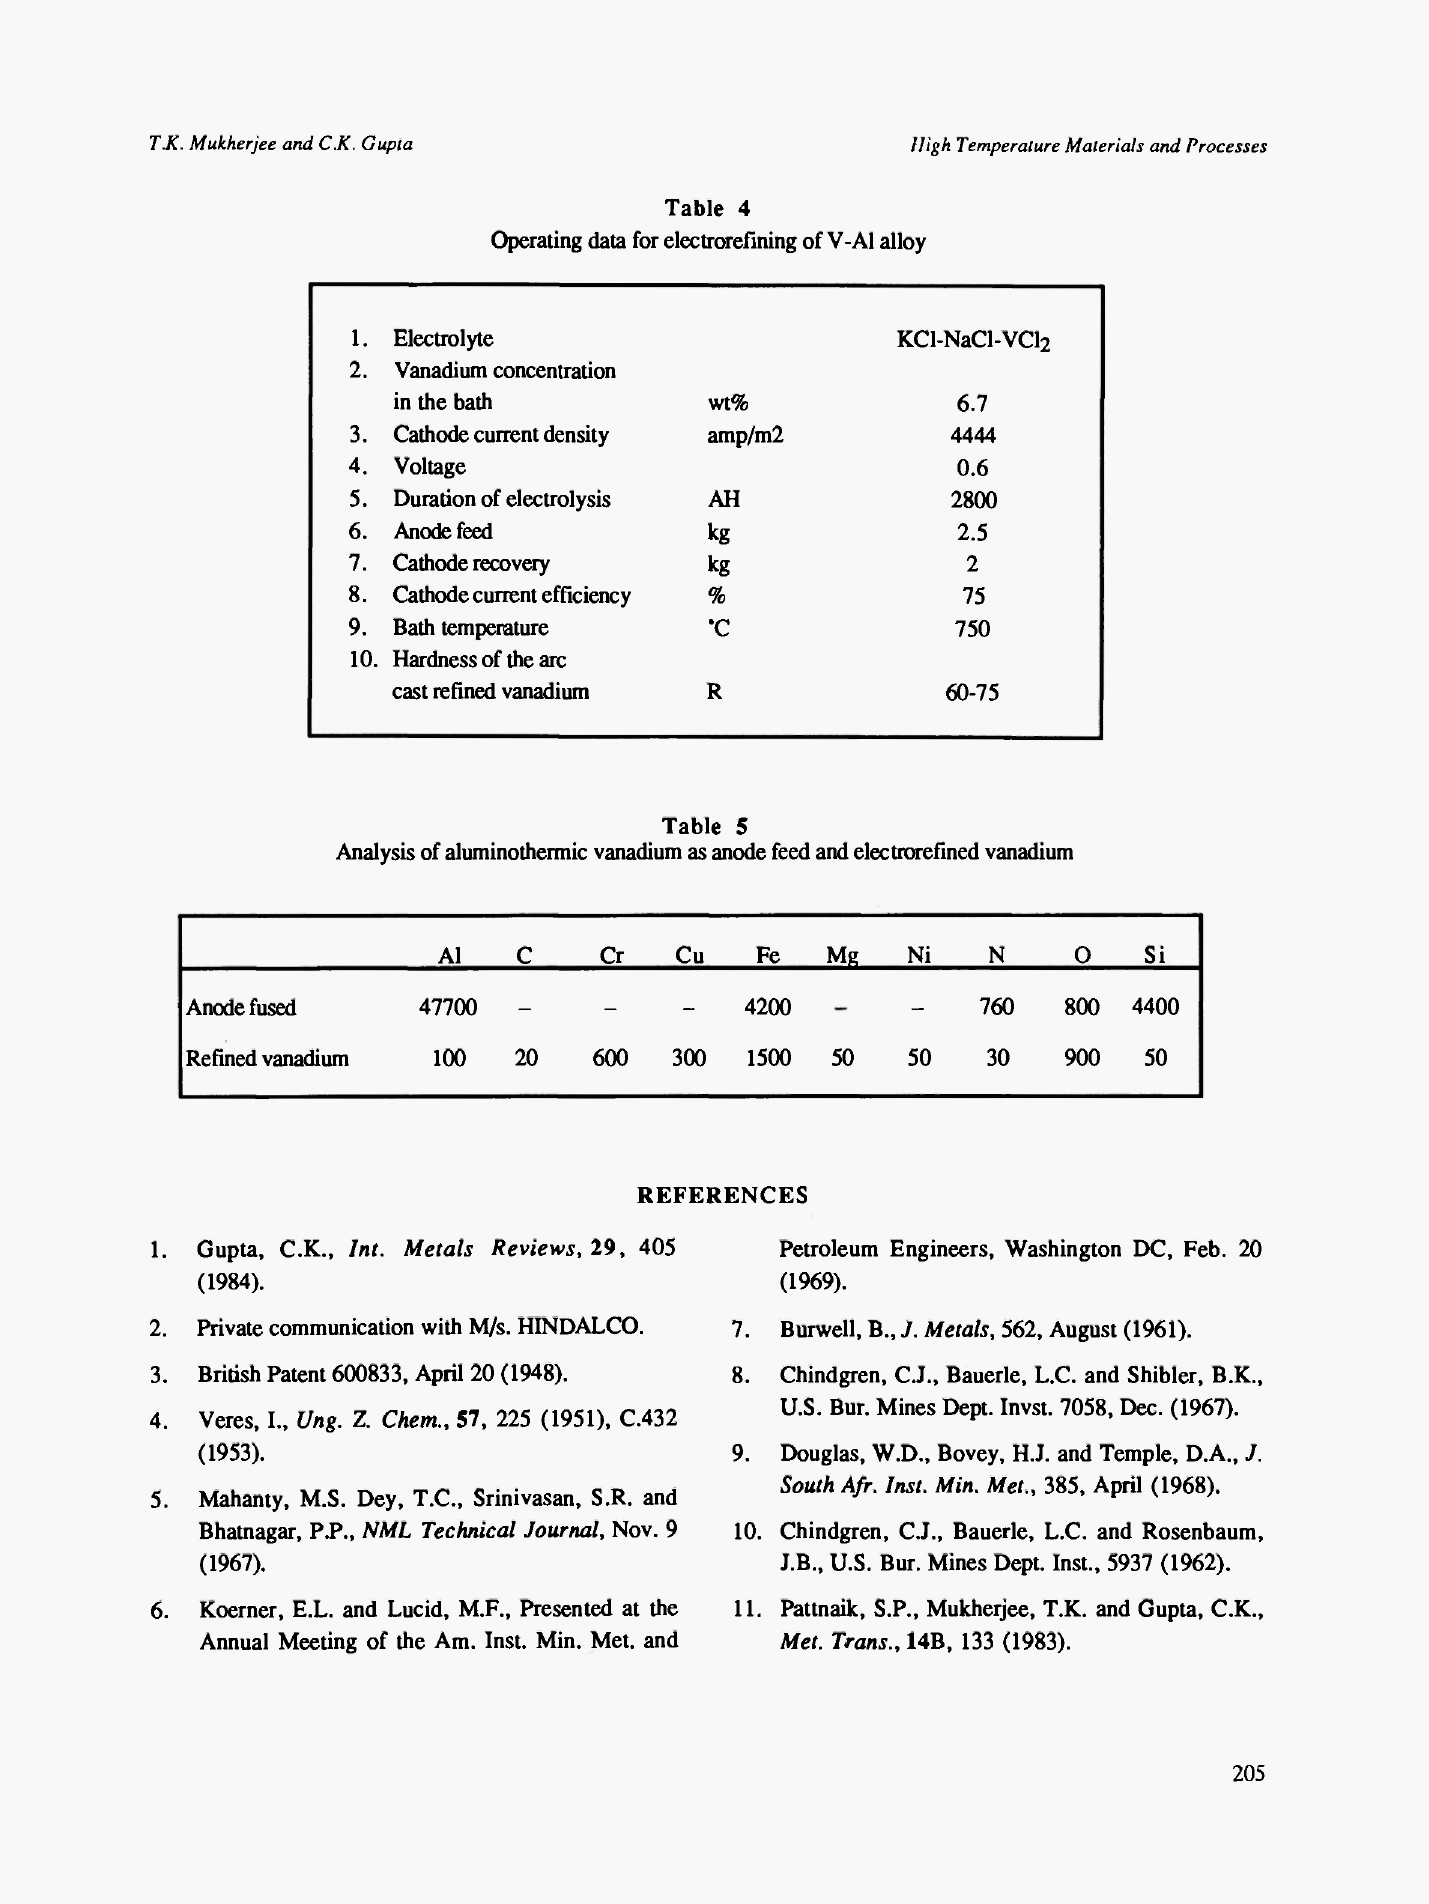
Analysis of aluminothermic vanadium as anode feed and electrorefined vanadium